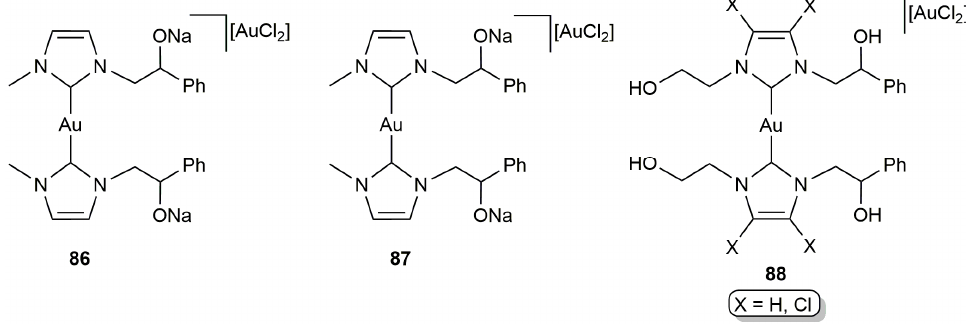
Figure 4. Structure of the hydrophilic bis-NHC gold(I) complexes 86 – 88 .